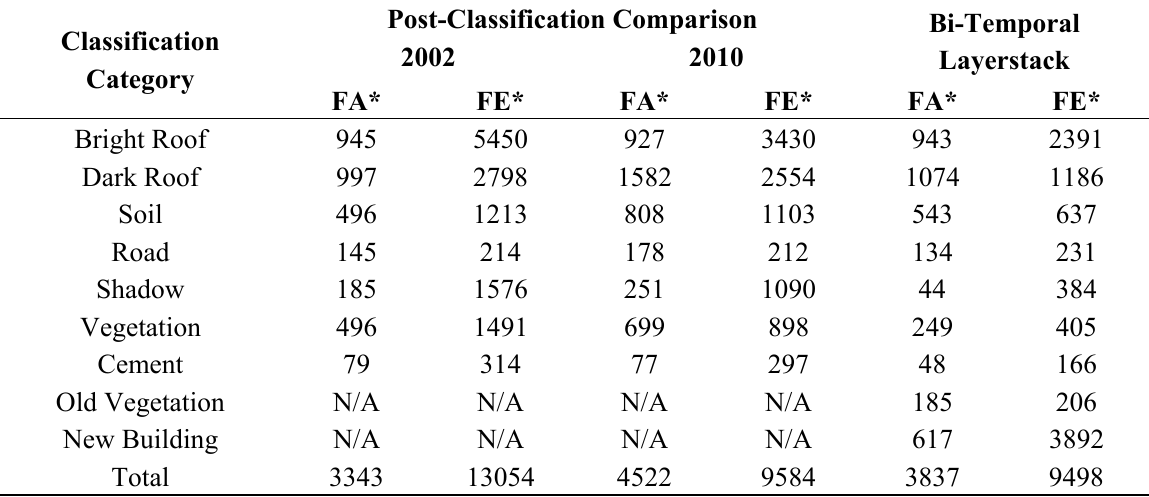
Table 1. Number of Training Objects Used in Feature Analyst and Feature